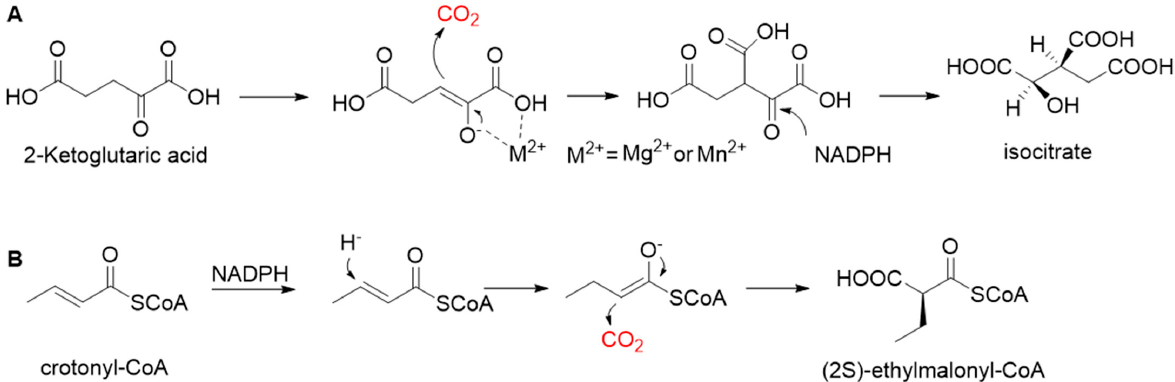
Figure 3. The catalytic mechanism of isocitrate dehydrogenase and crotonyl-CoA carboxylase/reductase. ( A ) The catalytic mechanism of isocitrate dehydrogenase [44]. ( B ) The catalytic mechanism of crotonyl-CoA carboxylase/reductase [45].